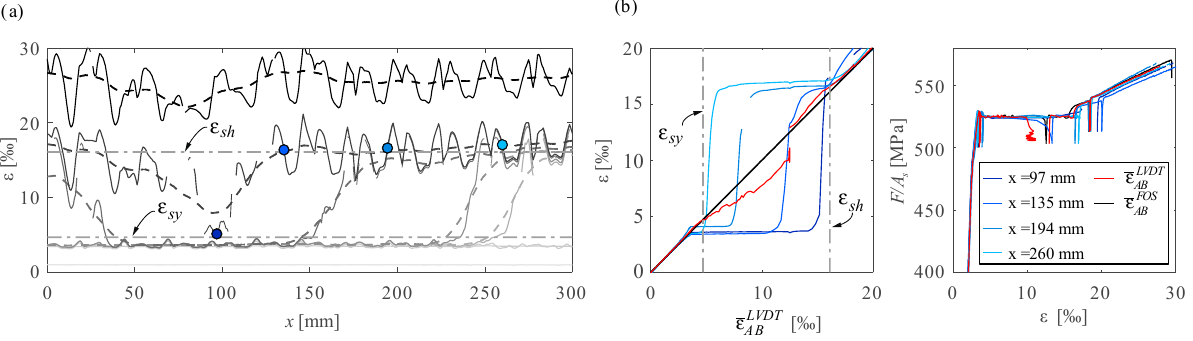
Figure 8. Quenched and self-tempered reinforcing bar qst01 tested under direct tension and instrumented with polyimide coated fibre glued inside a groove: ( a ) DFOS strain distribution at selected strain levels and ( b ) comparison of local DFOS strains at marked points with mean strains by LVDTs and DFOS, and resultant stress-strain behaviour.